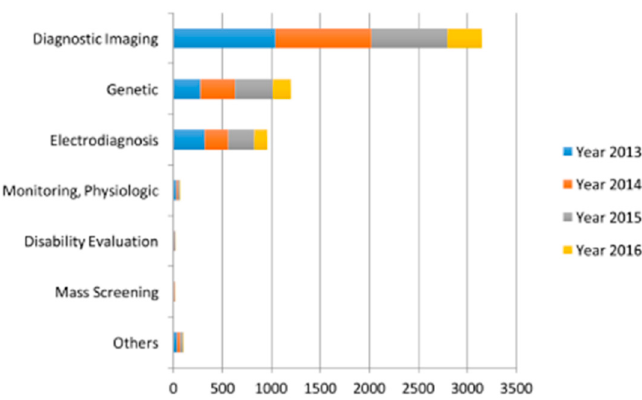
Figure 1. Types of data considered in AI related studies (PubMed database) [3].